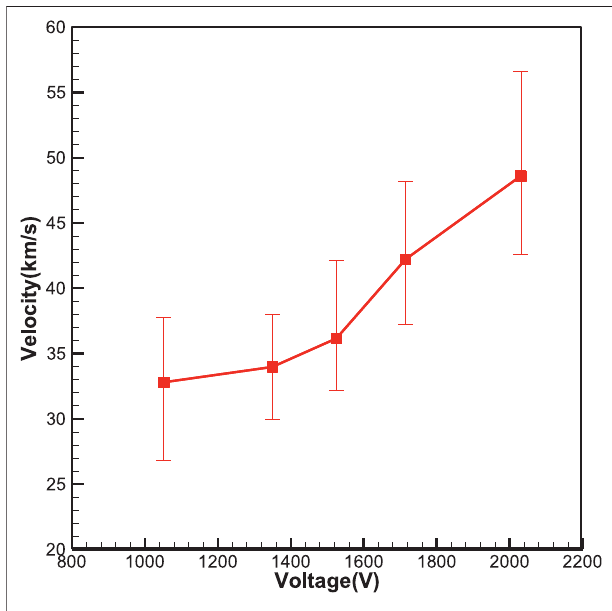
FIGURE 5 | Plasma movement velocity of APPT at different initial